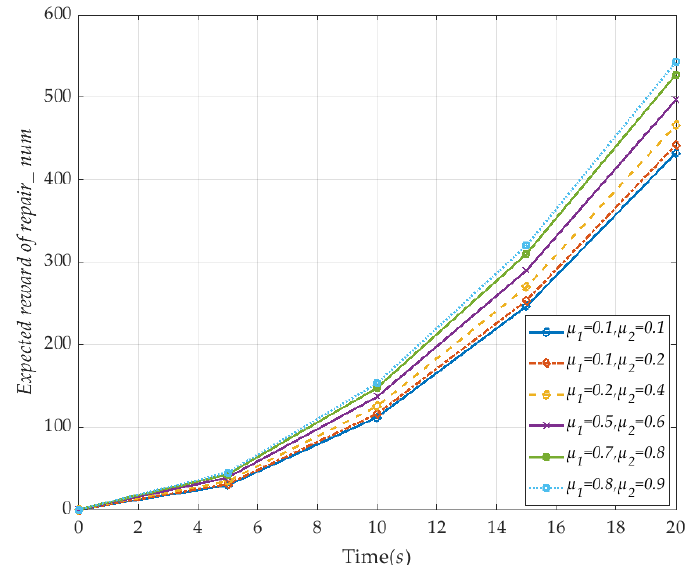
Figure 12. The expected repair number reward of the the V2I network with time (corresponding to µ 1 and µ 2 ).